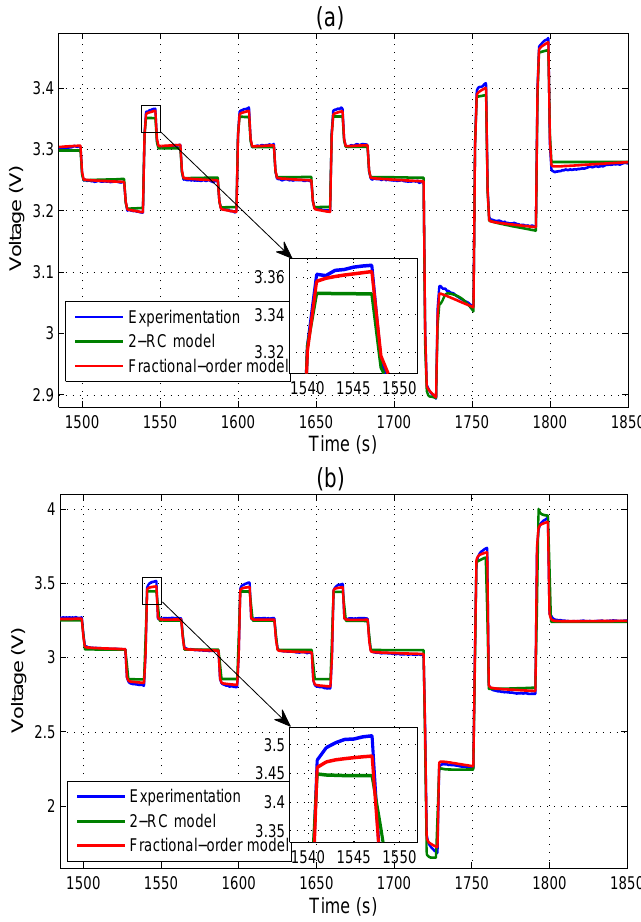
Figure 10. ( a ) Comparison of actual voltages for the one single in cycle DST, 2 ‐ RC model output voltages and fractional ‐ order model output voltages: WB ‐ LYP40AHA; ( b ) Comparison of actual voltages for the one single in cycle DST, 2 ‐ RC model output voltages and fractional ‐ order model output voltages: LiFePO 4 .